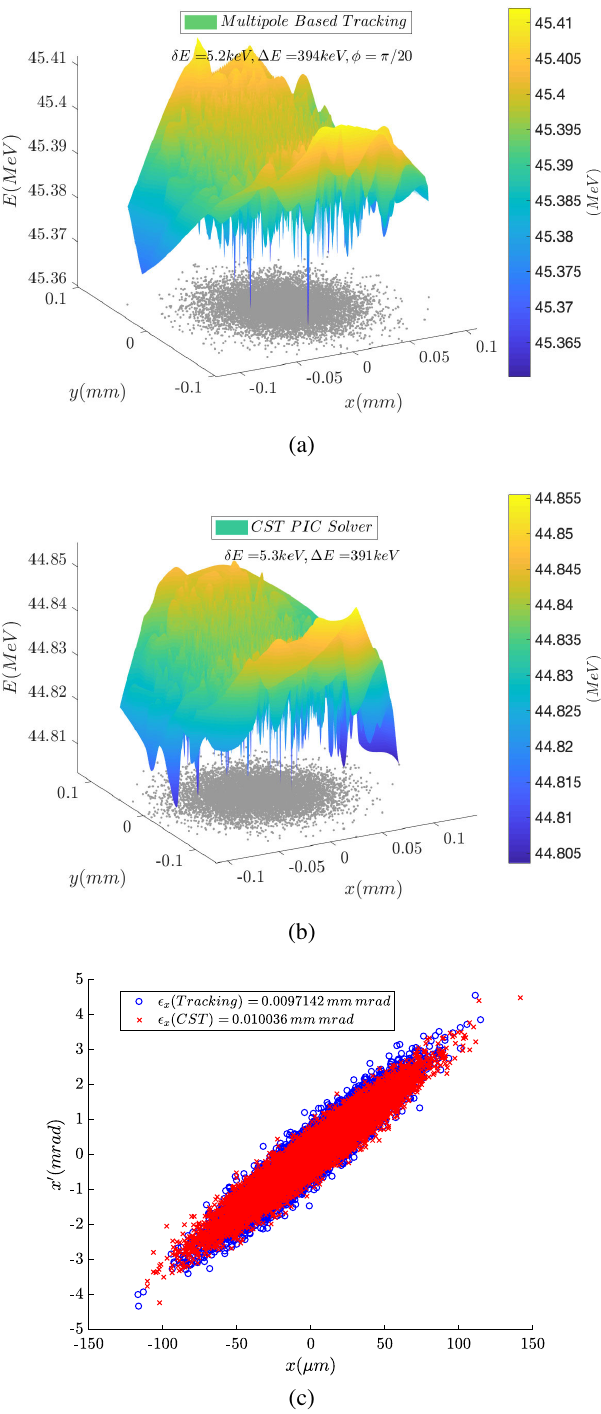
FIG. 20. The beam energy distribution in the x - y plane after 4 mm copropagation with the accelerating polarity of the THz field (a) using multipole based tracking and (b) as a result of the CST PIC solver. The particle distributions with rms radius of 10 μ m and slice length of 25 fs in the transverse plane are denoted with gray dots and the initial rms total energy is 45 MeV for both cases. The CST PIC solver presents only the kinetic energy. The transverse phase space distributions are presented in